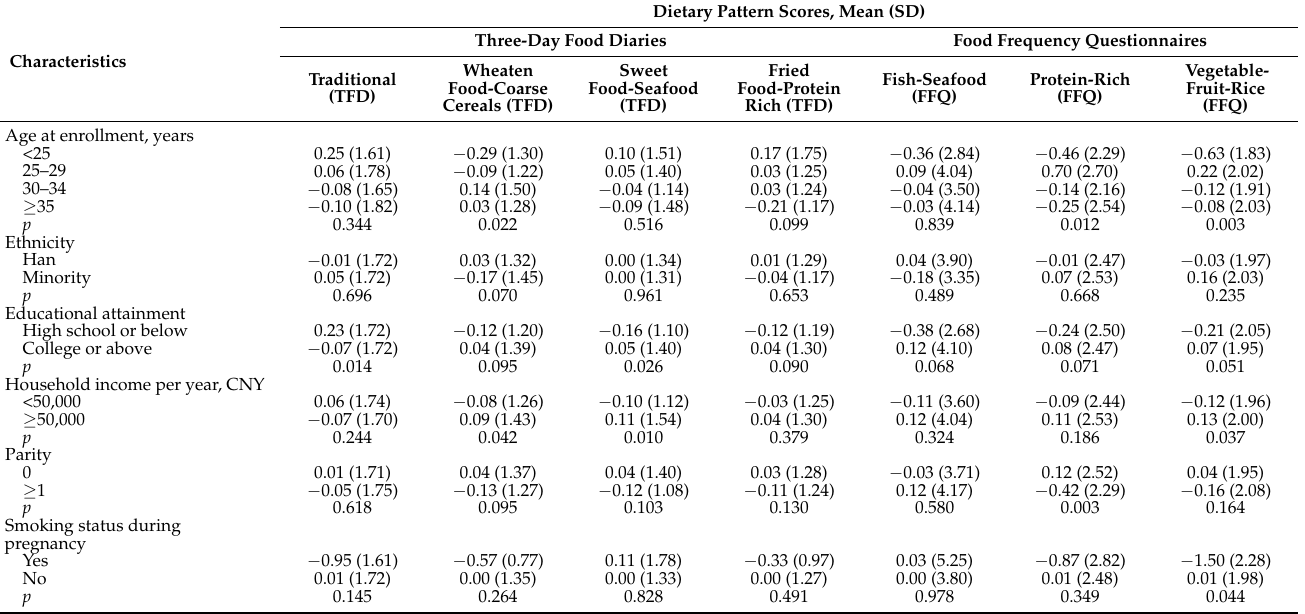
Table 2. Dietary pattern scores according to participants’ characteristics among 1089 participants in the “Born in Shenyang”